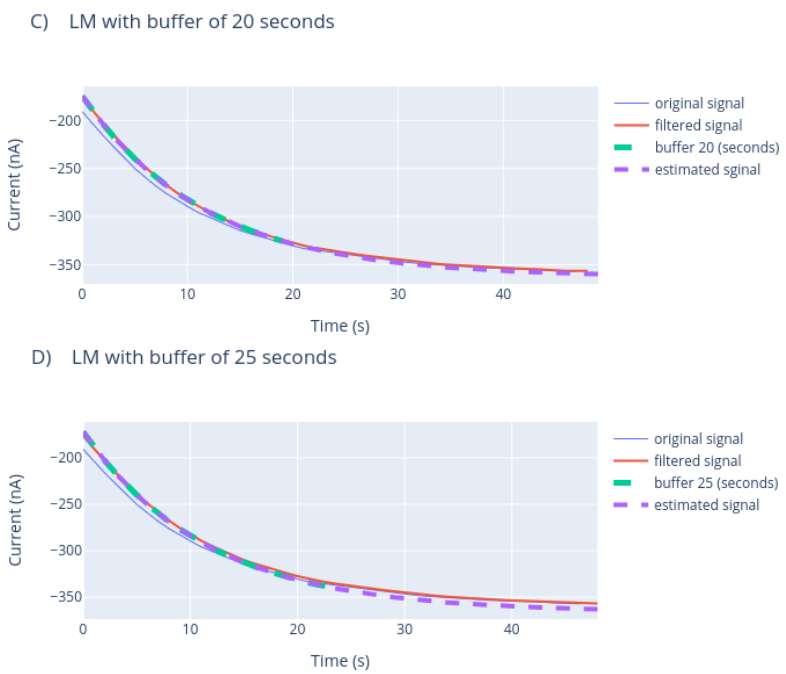
Figure 15. LM approach curve estimation with different buffer lengths. The length of the buffer corresponds to